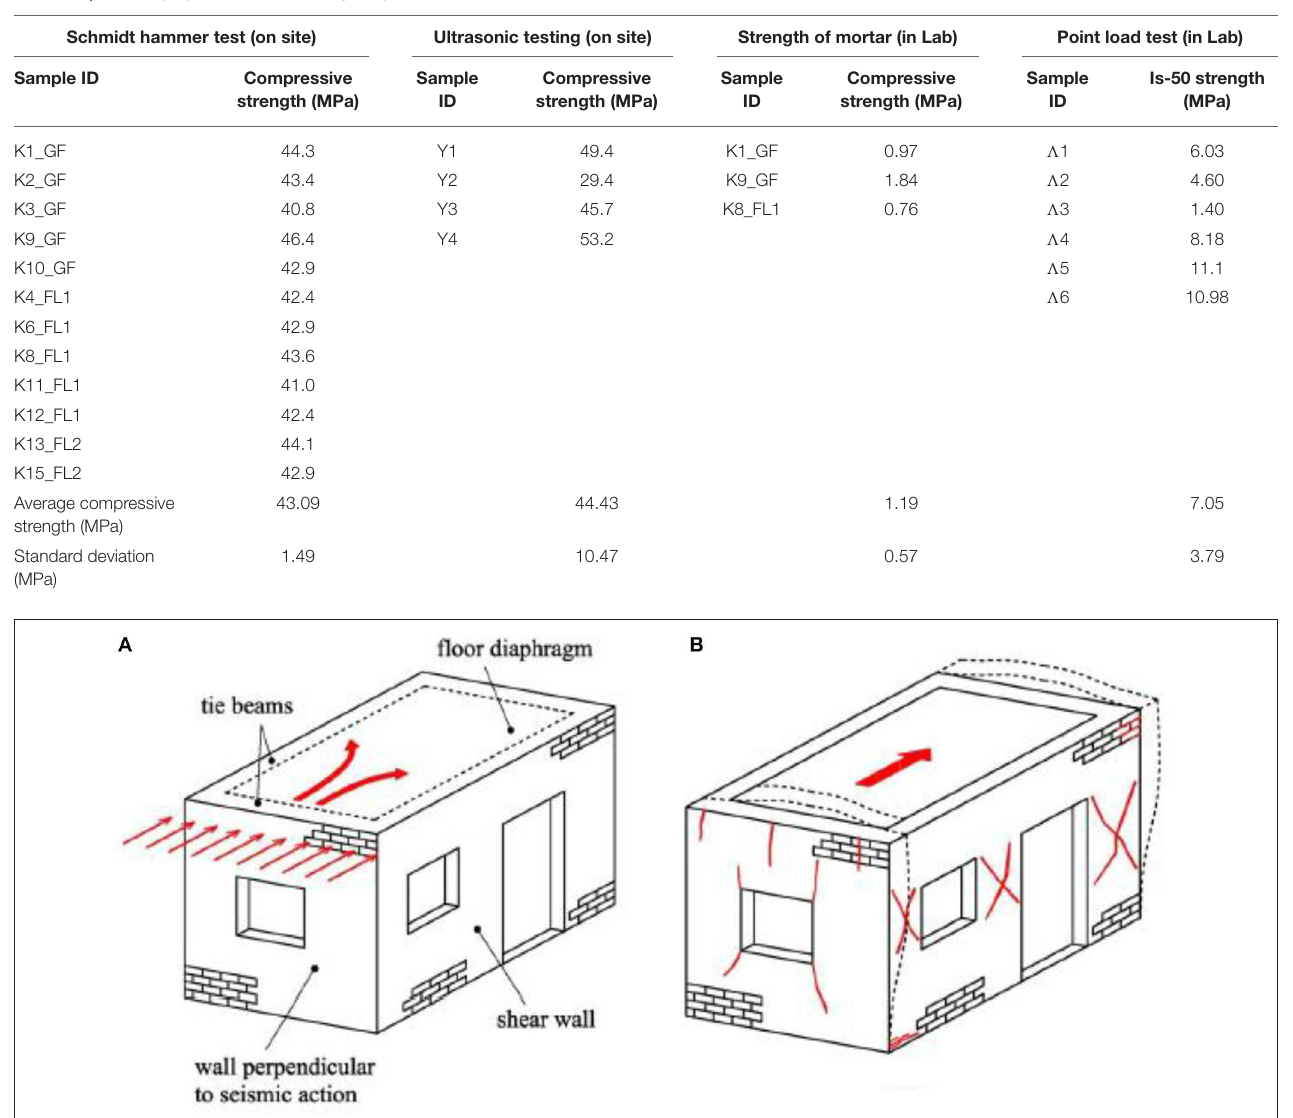
the other under compressive stresses, and the associated vertical crack was at the intersection of the